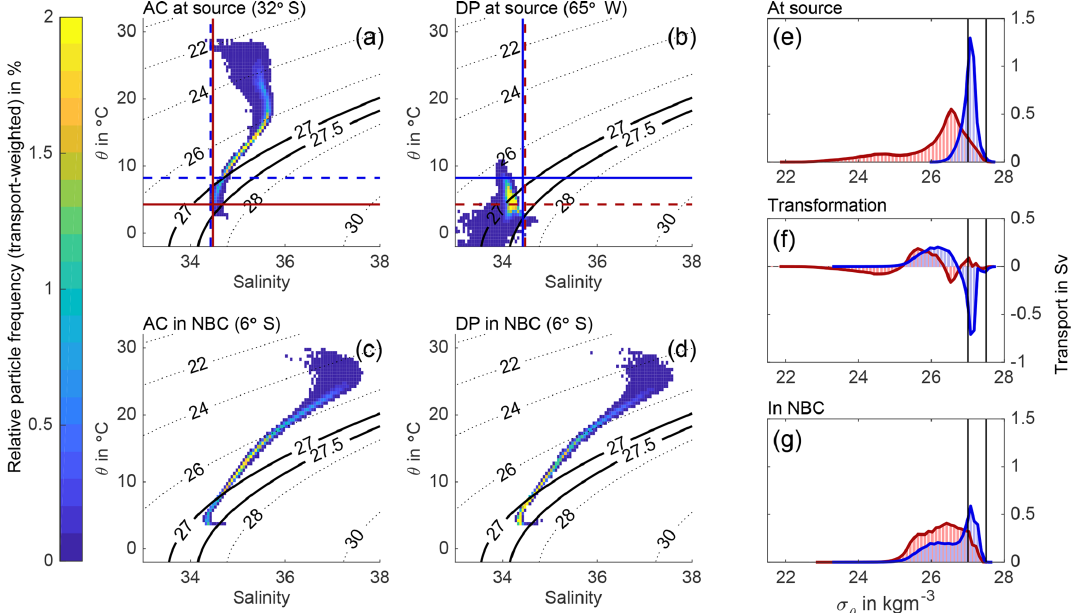
Figure 7. Thermohaline properties of waters with AC and DP origin inferred from all 10 REF experiments. (a–d) Mean potential temperature ( θ ) and salinity ( S ) characteristics of AC and DP waters at their source and within the NBC: relative transport-weighted particle frequency per 0.5 ◦ C × 0.1psu bin in percent (color shading); initially, 99% of the DP (AC) water volume can be found at temperatures colder (warmer) than 8.5 ◦ C (4.0 ◦ C) and at salinities lower (greater) than 34.45, as indicated by blue (red) lines. (e–g) Mean volume transport per density class (in 0.1kgm − 3 bins) of AC (red) and DP (blue) waters at their source and within the NBC, as well as associated transformation in density space (bar graphs); potential density levels used to separate upper, intermediate, and deep waters are highlighted by solid black